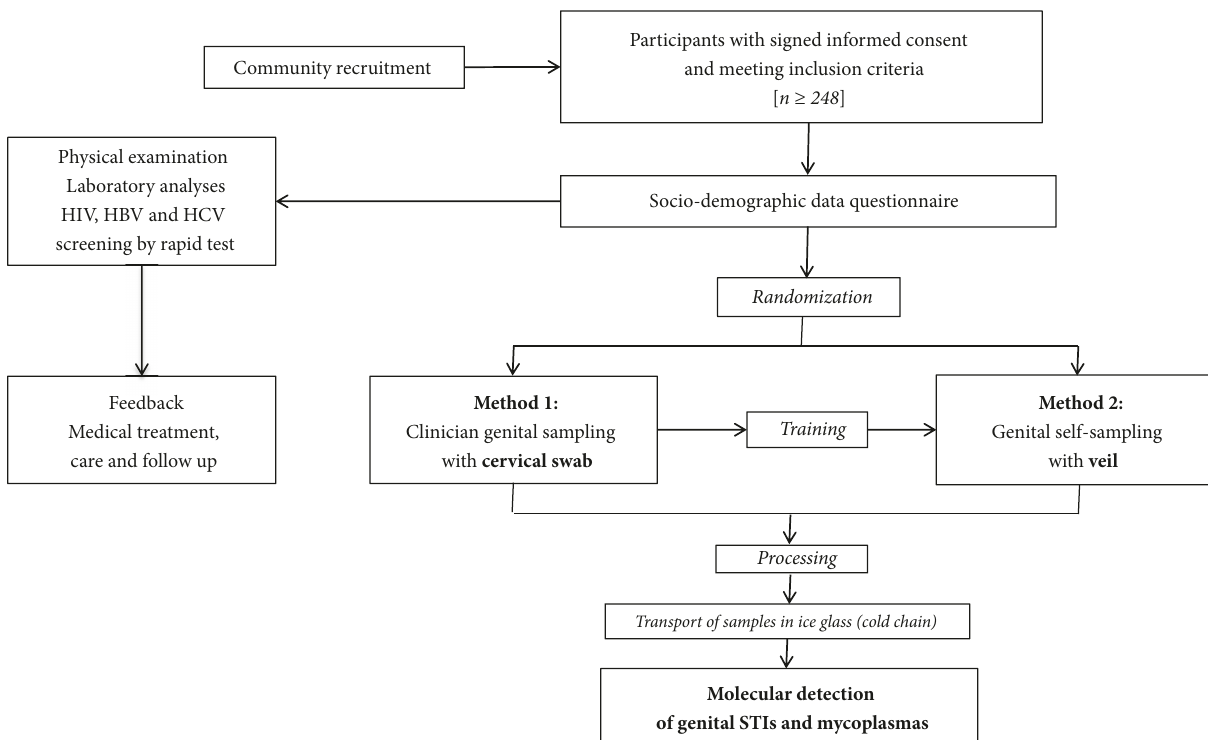
Figure 1: Flow diagram of the GYNAUTO-STI study . The GYNAUTO-STI study consisted in community-based recruitment of at least 248 adult women recruited from the community and further referred to the gynecologic clinic “ La Renaissance Plus ”, N’Djamena, Chad. The participants meeting the inclusioncriteria were subjected tophysical examination, tested for 3 chronicviral infections endemic in Chad (HIV, HBV, and HCV) by capillary-based immunochromatographicrapid test, cared when needed, and filled in the face-to-face sociodemographic questionnaire. Afterwards, the participants were trained for self-sampling collection using the V-Veil-Up Gyn Collection Device (V-Veil-Up Pharma Ltd.) and randomly submitted to the sampling procedure with Method 1 (clinician-based collection of cervical secretions by swab, as gold standard) followed by the Method 2 (self-collection by veil) or inversely. Collected samples were processed for molecular detection of genital sexually transmitted infections (STIs) and commensal Mycoplasmas